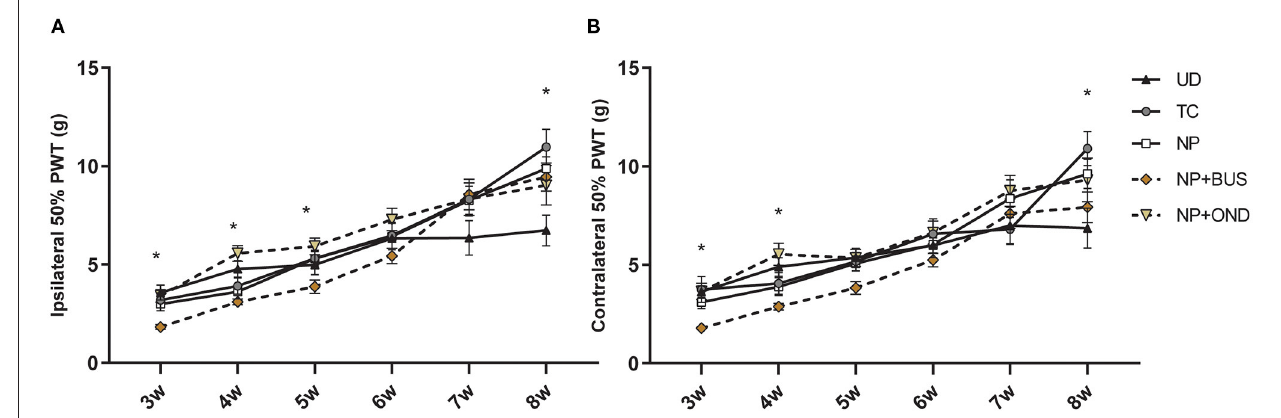
FIGURE 4 | Mechanical sensitivity to von Frey filaments throughout development. (A) Ipsilateral PWTs increase over time for all groups [F (3.048, 164.6) = 105.2, p < 0.01], but show a significant time*condition interaction [F (20,270) = 2.865, p < 0.01]. Posthoc analysis revealed a lower PWTs for the NP + BUS animals as compared to NP (at 3 and 4 weeks), NP + OND (at 3, 4, and 5 weeks), TC (at 3 weeks) and UD animals (at 3 and 4 weeks). NP and TC animals show higher PWTs at 8 weeks as compared to UD animals. (B) Contralateral PWTs increase over time for all groups [F (23.319, 179.2) = 81.69; p < 0.01], but show a significant time*condition effect [F (20, 270) = 2.104, p < 0.01]. Lower PWTs for the NP + BUS animals as compared to NP (at 3 weeks), NP + OND (at 3 and 4 weeks) and UD (at 3 and 4 weeks) are noted. Significantly higher PWTs are noted in NP and TC animals as compared to UD animals at 8 weeks. NP, needle prick animals; NP + BUS, needle prick animals receiving buspirone; NP + OND, needle prick animals receiving ondansetron; PWT, paw withdrawal threshold; TC, tactile control animals; UD, undisturbed control animals. Data is presented as mean ± SEM, * P <